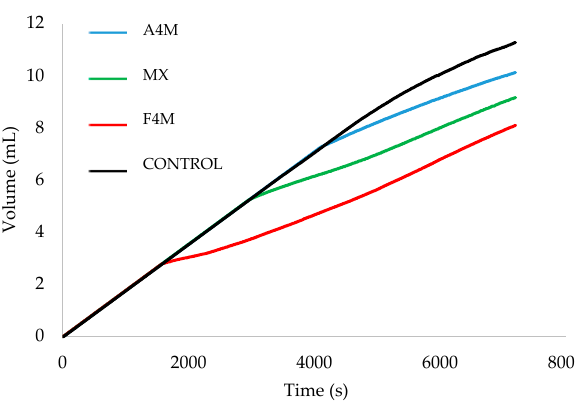
Figure 4. Volume of NaOH consumed during intestinal digestion of the studied spreads. Table 3. FFA release at the end of the in vitro digestion expressed as a mean ± standard deviation. Spreads FFA